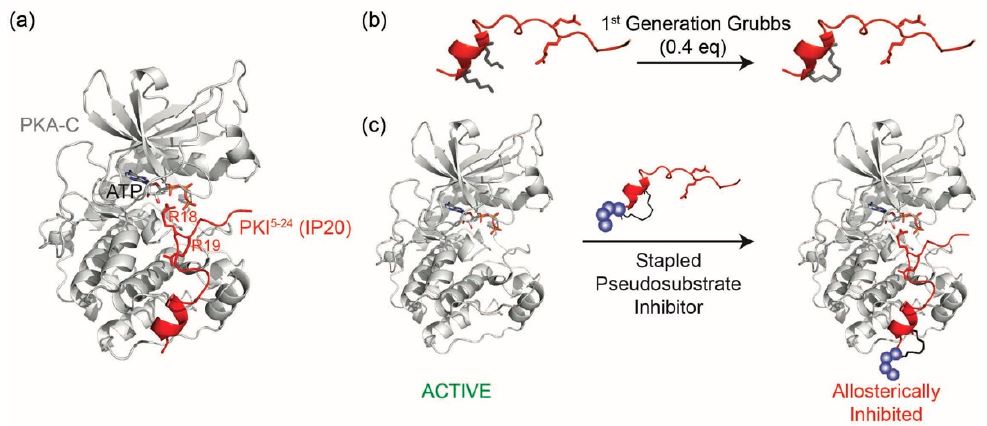
Figure 1. Design of a stapled pseudosubstrate inhibitor for the catalytic subunit of Protein Kinase A (PKA-C): ( a ) Crystal structure of PKA-C (gray, PDB ID: 1ATP) bound to a Protein Kinase Inhibitor (PKI 5–24 ) (IP20, red). The side chains of Arg 18 and 19 are shown and are critical for pseudosubstrate inhibition; ( b ) Peptide stapling was performed on-resin with ring-closing metathesis chemistry using